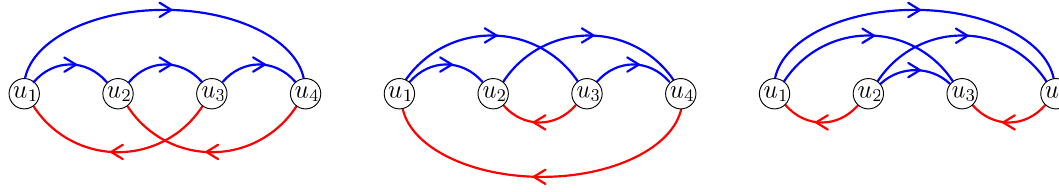
Figure 4 . The three dynamical structures entering the four-scalar FF transition, (4.5). Each of them factorizes into six two-particle FF transitions. A blue line from u ( u ) , while a red one represents a factor of 1 /F F i , u j φ ¯ φ invariant under crossing, while the other two are